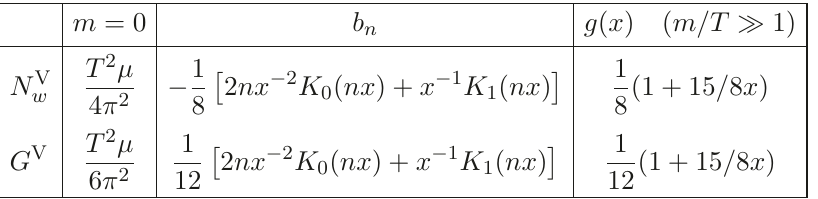
Table 4 . The vector current coefficients (6.3) for an ideal Dirac field: the first column is the result at m = 0, the second column is the generic terms of the series expansion (8.4), the third column is the asymptotic expansion for low temperature